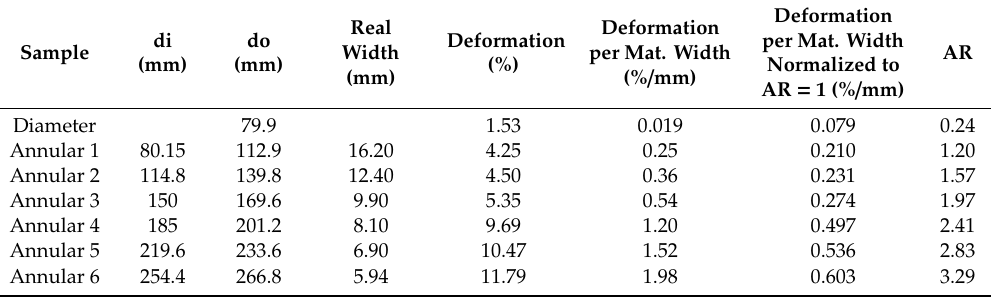
Table 6. Deformation of samples related to material width and aspect